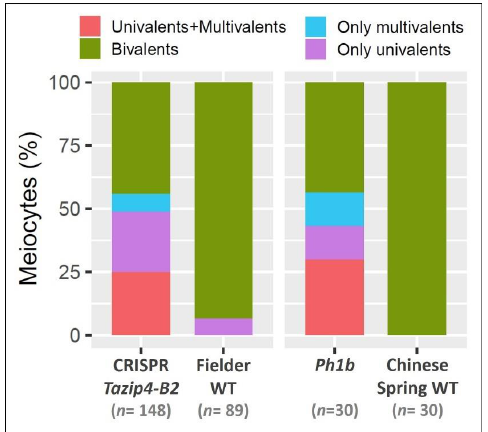
Figure 2. The percentage of meiocytes with meiotic abnormalities from the CRISPR Tazip4-B2 and ph1b mutants, and their wild types. Data used to produce this figure is taken from Rey et al. [19] and Martín et al. [38]. n refers to the number of scored meiocytes. Table 1. Summary of the meiotic scores for the two Tazip4-B2 mutants and their corresponding wild types.